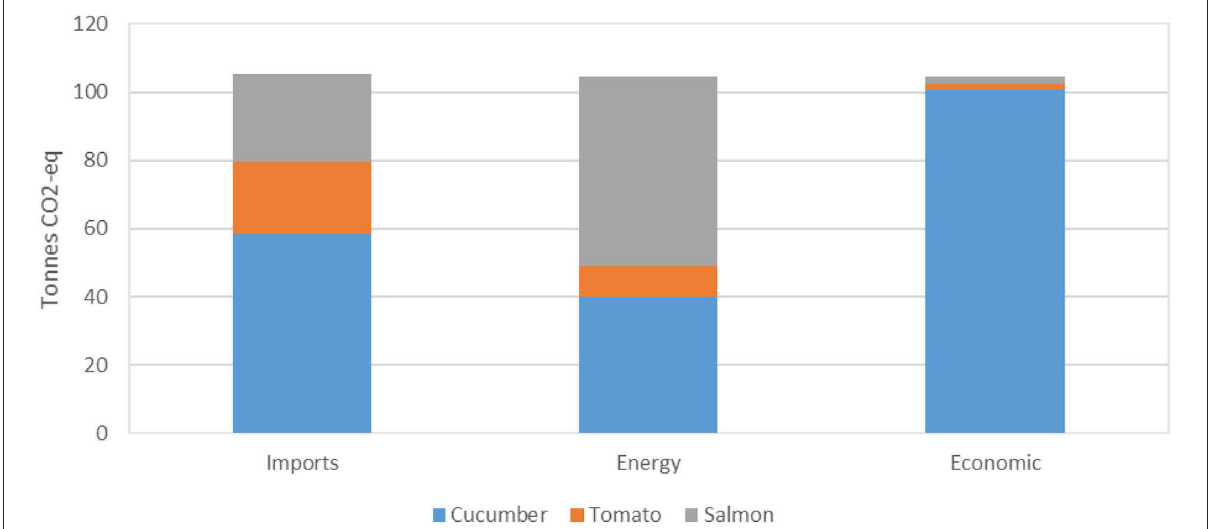
FIGURE5 Comparison of GWP from the aquaponics’ harvest as opposed to importing the same amount of items at retailer’s gate. Further details on the calculations are provided in Supplementary Tables A4,